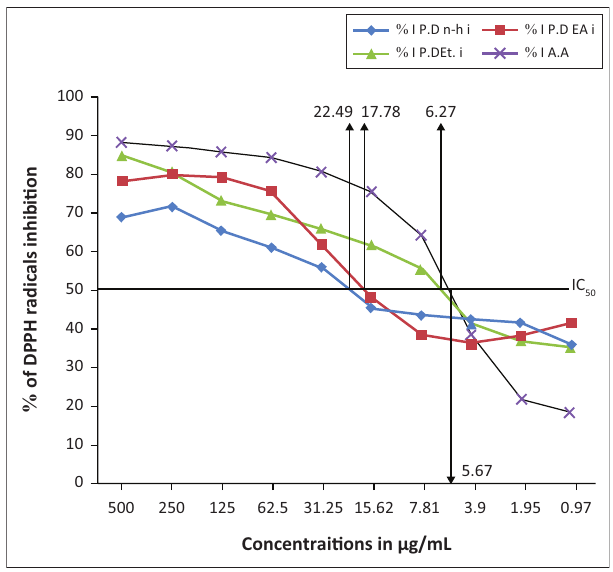
% I, percentage inhibition; P.D, Pergularia daemia ; n-h, n-hexane; EA, ethyl acetate; Et, Ethanol; A.A, ascorbic acid; l, leaf; s, stem. FIGURE 4: Percentage inhibition of DPPH (2,2-diphenyl-1-picrylhydrazyl) radical versus concentrations of leaf